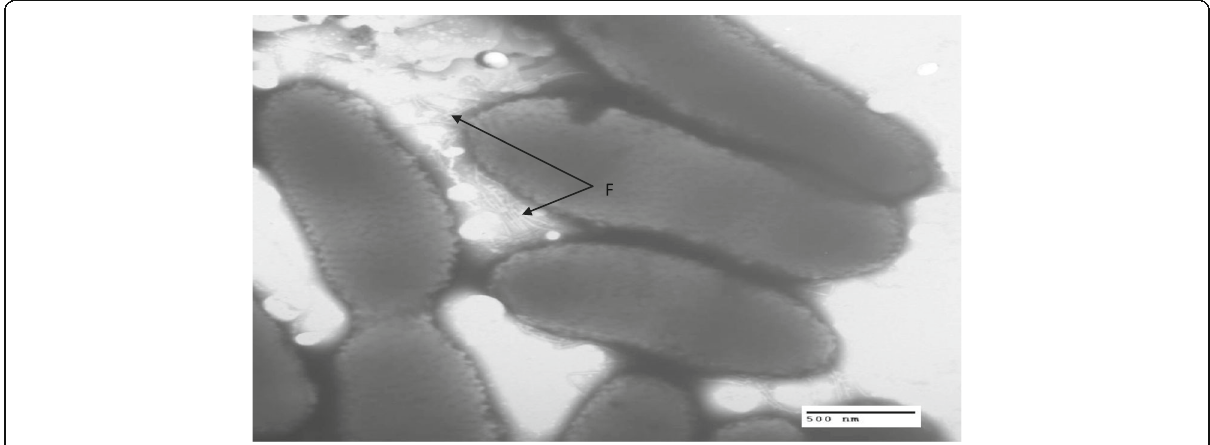
Fig. 2 Transmission Electron Microscopy negative stain of Paraburkholderia caballeronis TNe-841 T . The strain was grown on LB medium and a loop-full of cells was gently suspended in 1 mL distilled water. A drop of the suspension was placed on a formvar-coated copper grid and air-dried for 20 min to allow the cells to adhere. The grid was then covered for 20 s with a solution of 0.5% uranyl acetate, the excess liquid was removed with a filter paper, and then air-dried. A JEOL JEM-1010 transmission electron microscope, operated at 60 kV, was used to observe and photograph negatively stained preparations. F, stands for